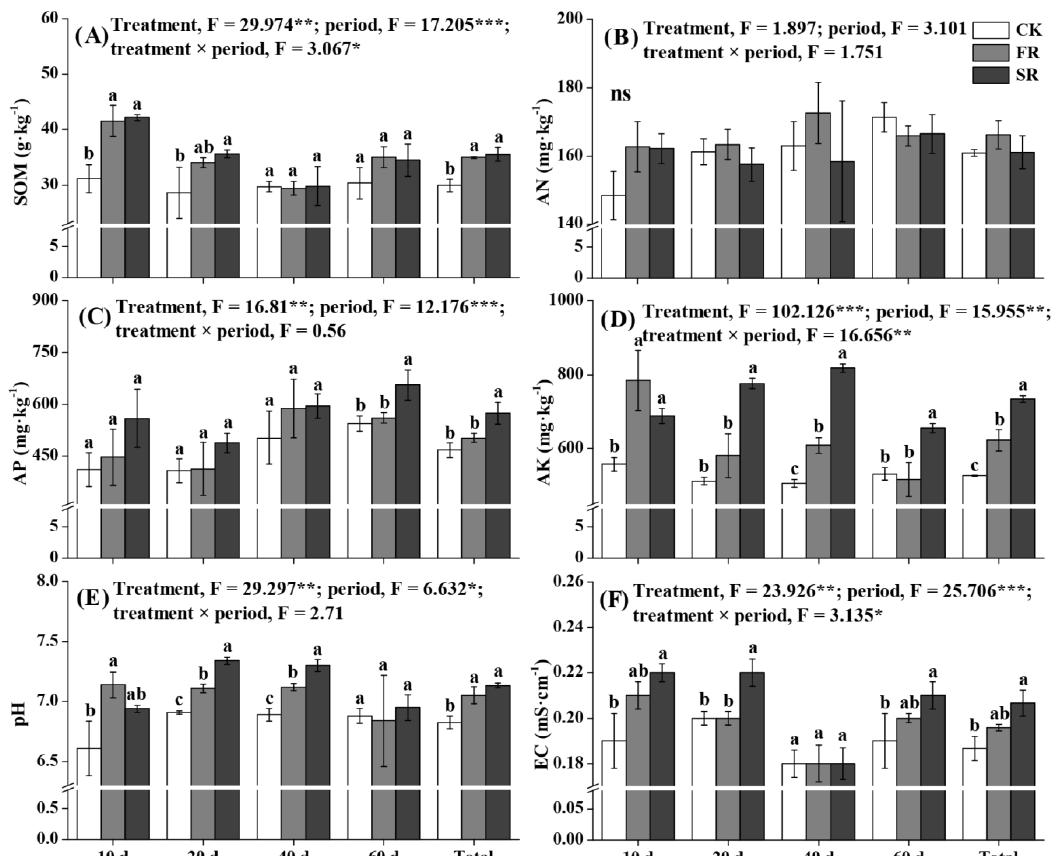
Figure 2. Soil chemical properties’ response to straw application. ( A ) soil organic matter (SOM), ( B ) alkaline hydrolytic nitrogen (AN), ( C ) available phosphorus (AP), ( D ) available potassium (AK), ( E ) pH and ( F ) electrical conductivity (EC). CK, no straw application; FR, one-year straw application; SR, two-year straw application. Labels of the abscissa axis indicate the survey time (days after sowing), and total indicates the mean value for each period. Error bars indicate the standard error, ns indicates no significant differences between treatments and different letters indicate significant differences at the 0.05 level (Tukey’s HSD test). The text in the figure represents the effects of the treatment and period based on the repeated-measures analysis of variance (ANOVA). * p < 0.05, ** p < 0.01 and *** p < 0.001.